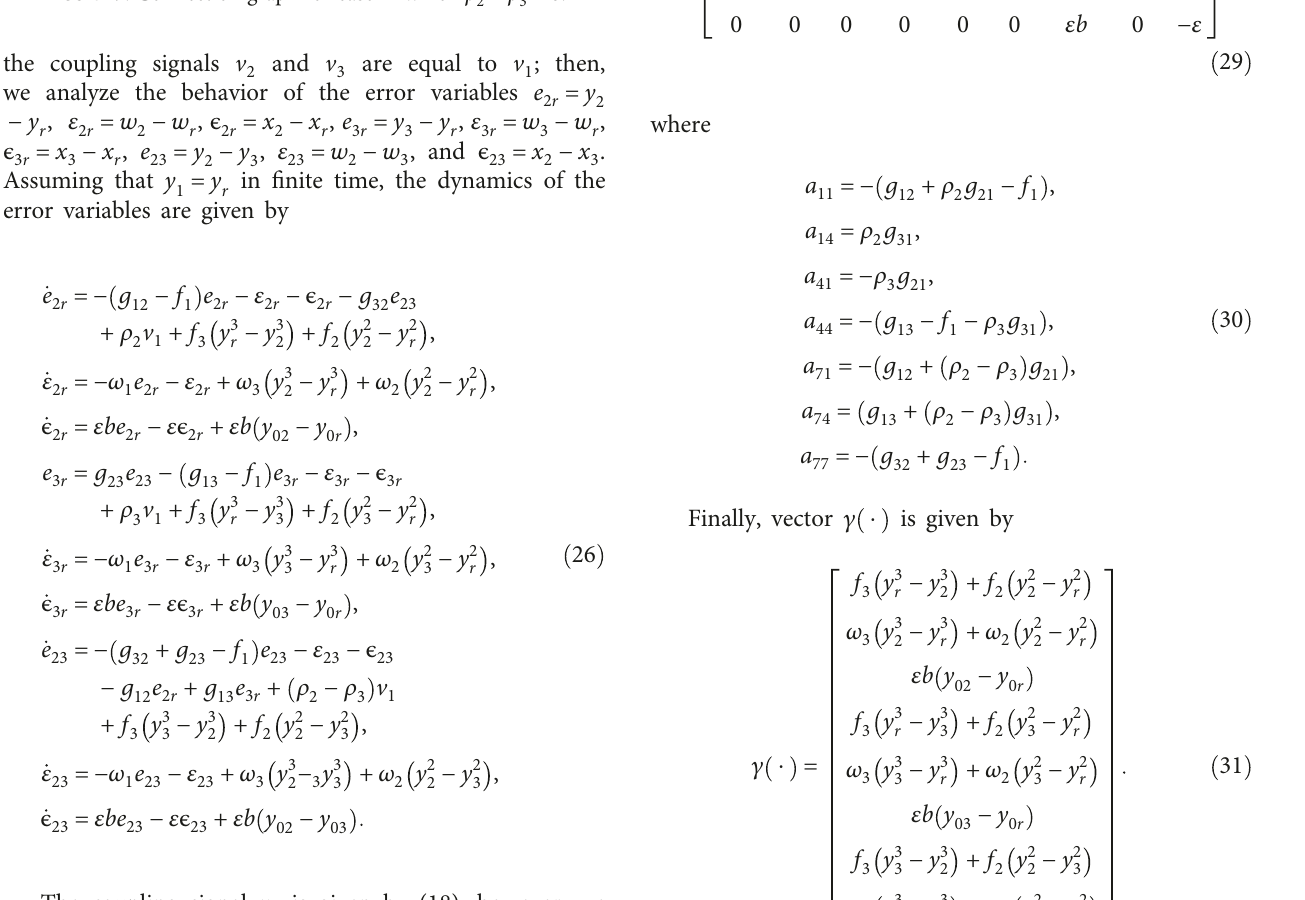
Figure 7: Connection graph for case in which ρ